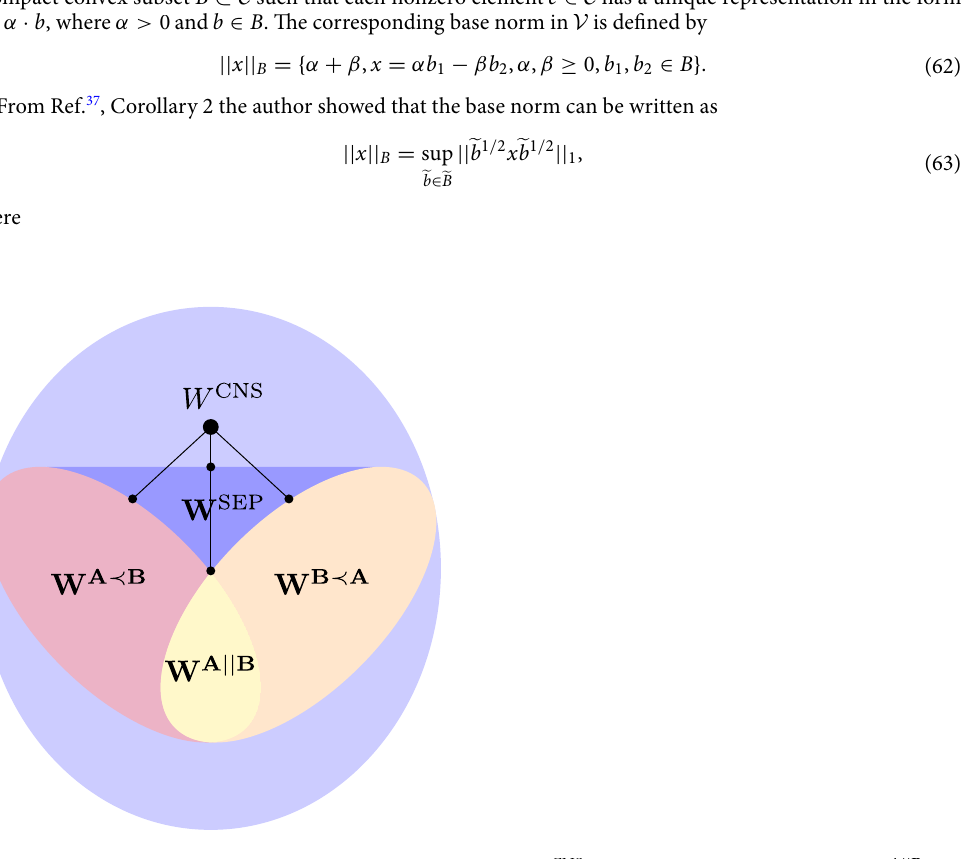
Figure 8. A schematic representation of the distances between W CNS defined in Eq. (56) and the sets W B B A SEP W A , W and W ≺ ≺